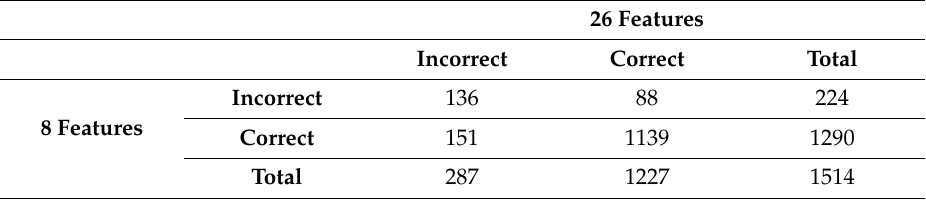
Table 7. Cross-tabulation of confusion matrices between SVM classifiers with eight and 26 features.